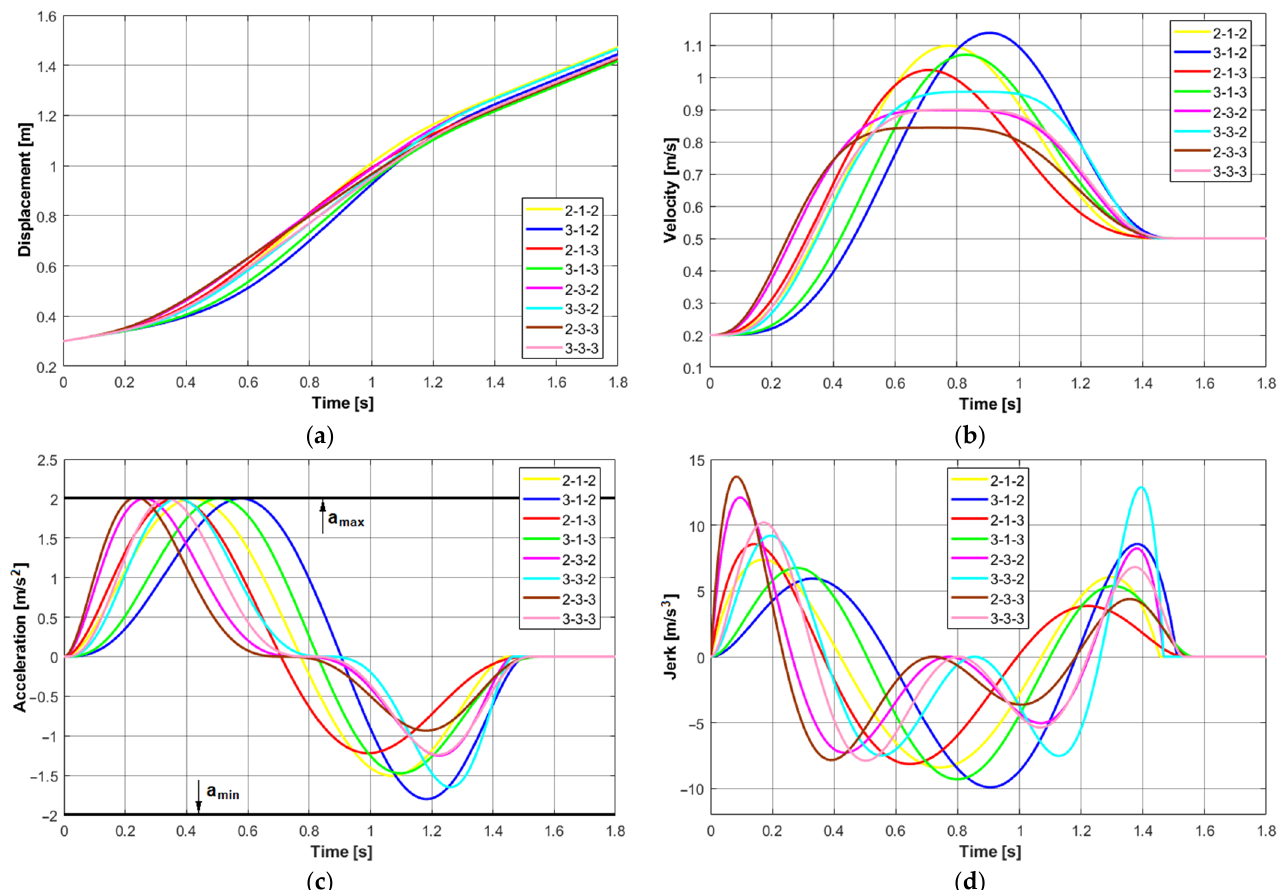
Figure 2. Profiles of kinematic quantities for the trajectories with the acceleration constraint: ( a ) displacement; ( b ) velocity; ( c ) acceleration; ( d ) jerk.